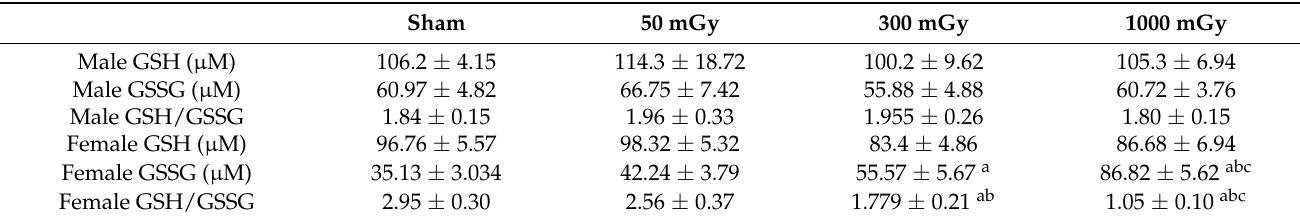
300 mGy, p ≤ 0.05. n = 11–19 per group. Data are presented as a mean ± SEM.